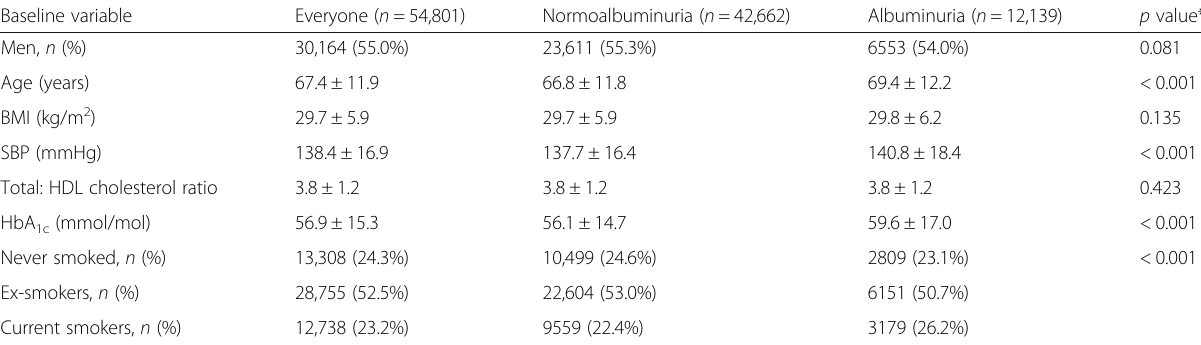
Table 1 Baseline characteristics of the study cohort, stratified by albuminuria status. Data represent means ± SD unless a percentage (%) is stated